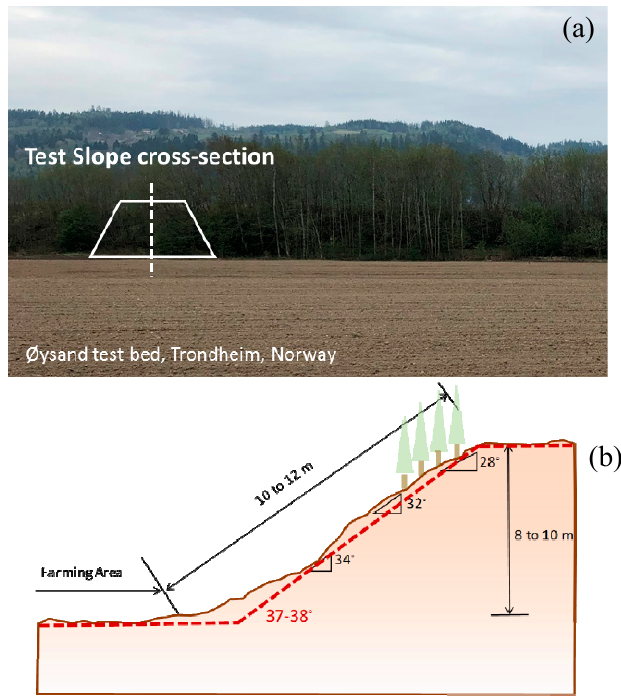
Figure 7. ( a ) Location and ( b ) cross-section of the instrumented slope at Øysand.